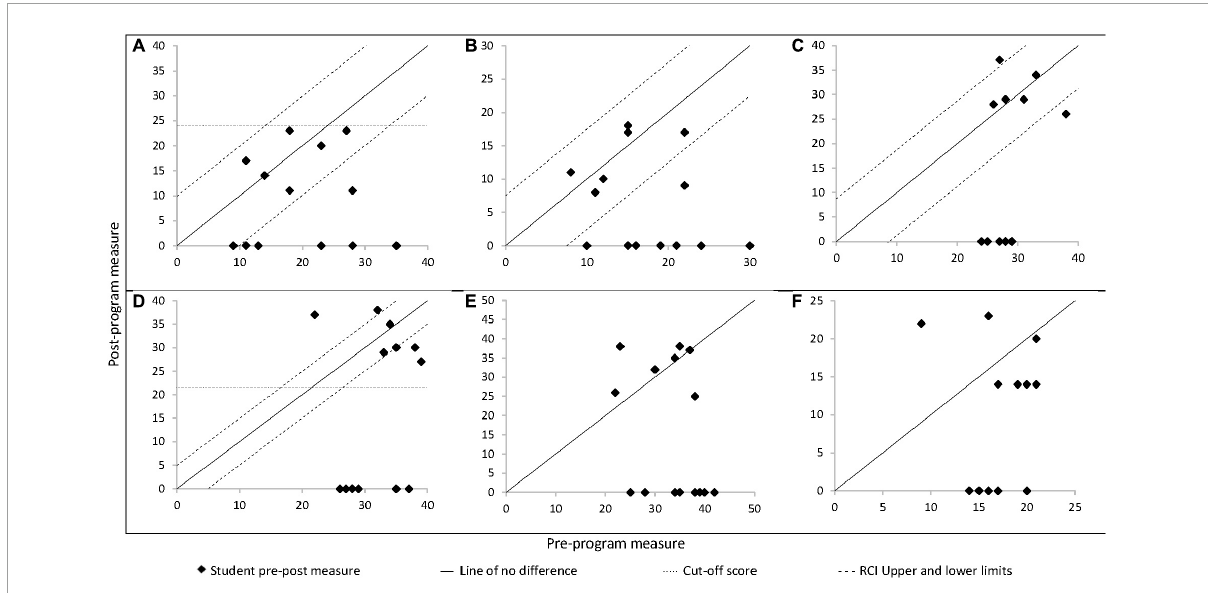
FIGURE1 Change score analysis pre-program ( N = 7). Pre-program date of post-program survey non-completers are shown on the x -axis of each panel for comparison. (A) AAQ-II, (B) distress, (C) acceptances, (D) GSE, (E) study habits, and (F) life habits. Upper and lower limits of reliable change and cut-off scores are included in measures with published estimates facilitation